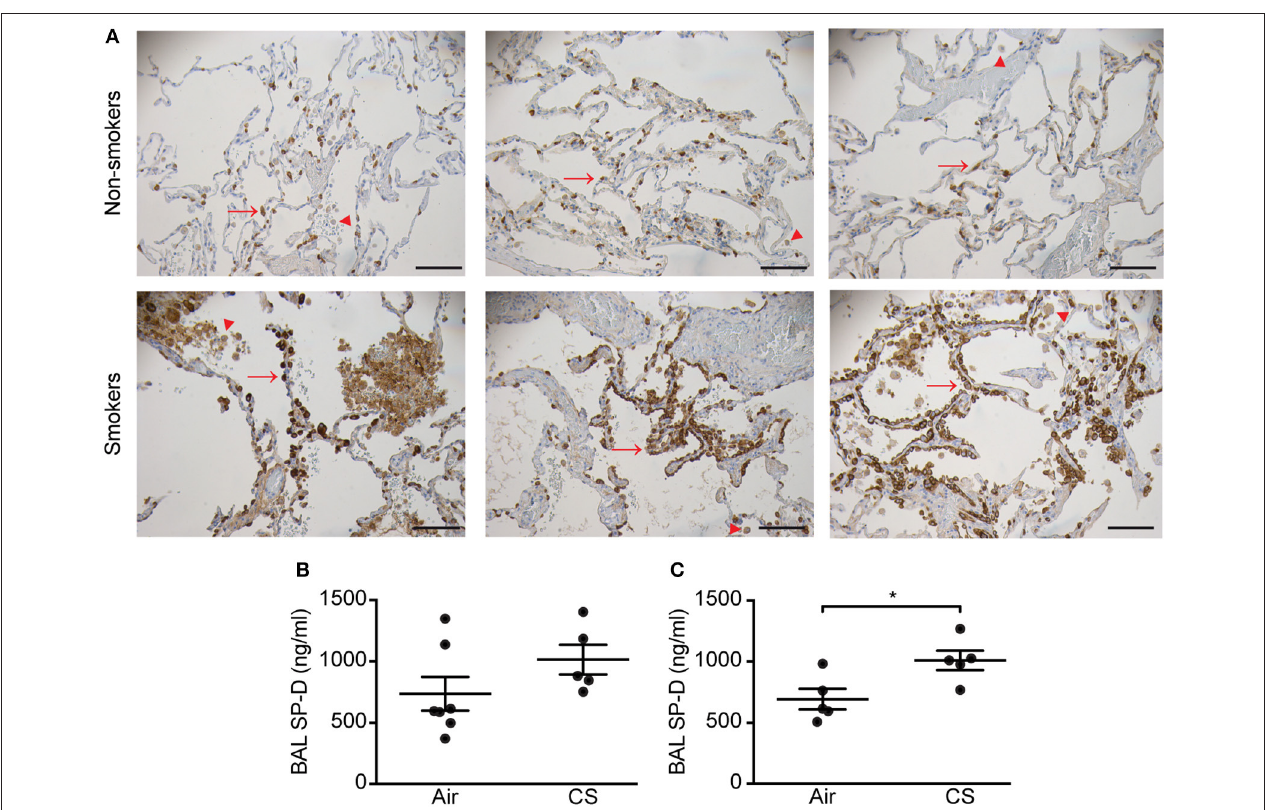
FIGURE 1 | Regulation of pulmonary SP-D levels by cigarette smoke (CS) in humans and mice. (A) Human SP-D is upregulated in the lungs of smokers compared to non-smoker controls. Each picture represents a single subject. Examples of alveolar type II cells and alveolar macrophages are marked with red arrows and arrowheads, respectively. Representative pictures are shown. Scale bar, 100 µ m. (B,C) Endogenous murine SP-D is upregulated in bronchoalveolar lavage fluid (BAL) after (B) 12 weeks and (C) 3 days of CS exposure. n = 5–7. * p < 0.05, analyzed by Student’s t